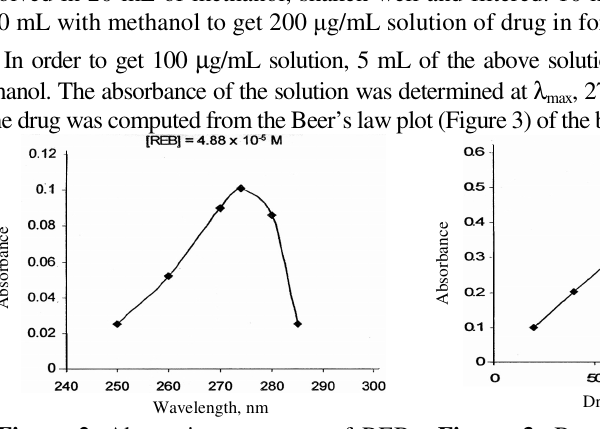
Figure 3. Beer’s law plot of REB in methanol (UV reference